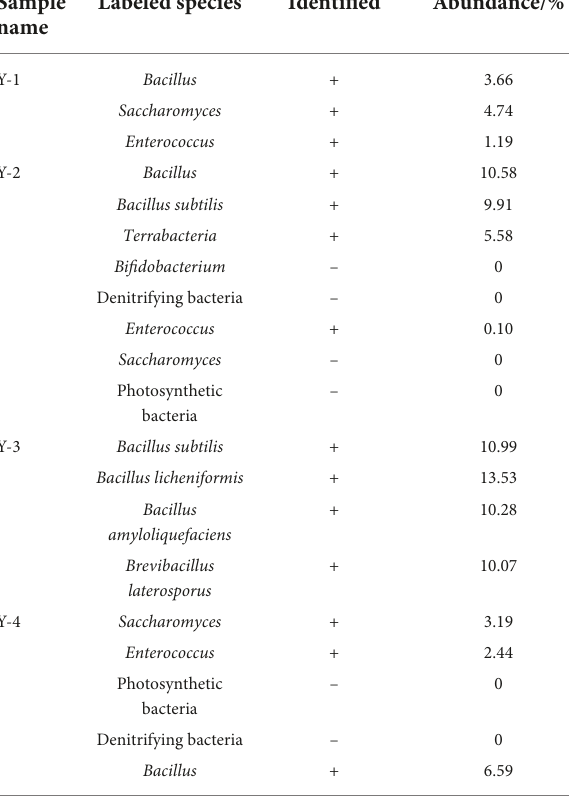
The microbial composition of four commercial microbial inoculants was then analyzed at the species level ( Figure 1 ).